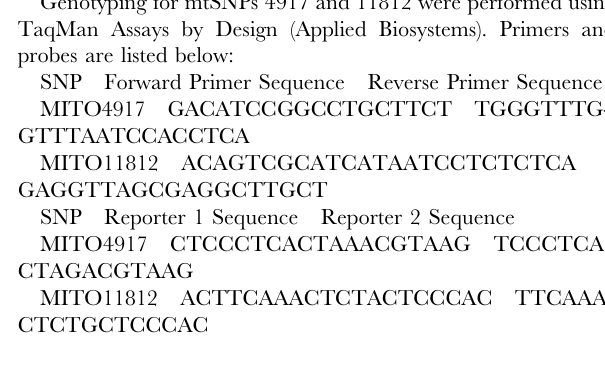
Table S1 Demographic and life-style characteristics of AREDS and BMES samples. All participants are self-identified as being of being of non-Hispanic white origin. AMD =age-related macular degenration; Adv. AMD =advanced AMD (geographic atrophy and or neovascular) AREDS =Age-Related Eye Disease Study; BMES = Blue Mountains Eye Study; GA= geographic atrophy; NV= neovascular; stderr = standard error. AREDS A and AREDS B cohorts are independent. Demographic data are for all participants with T1 or T2 base calls.